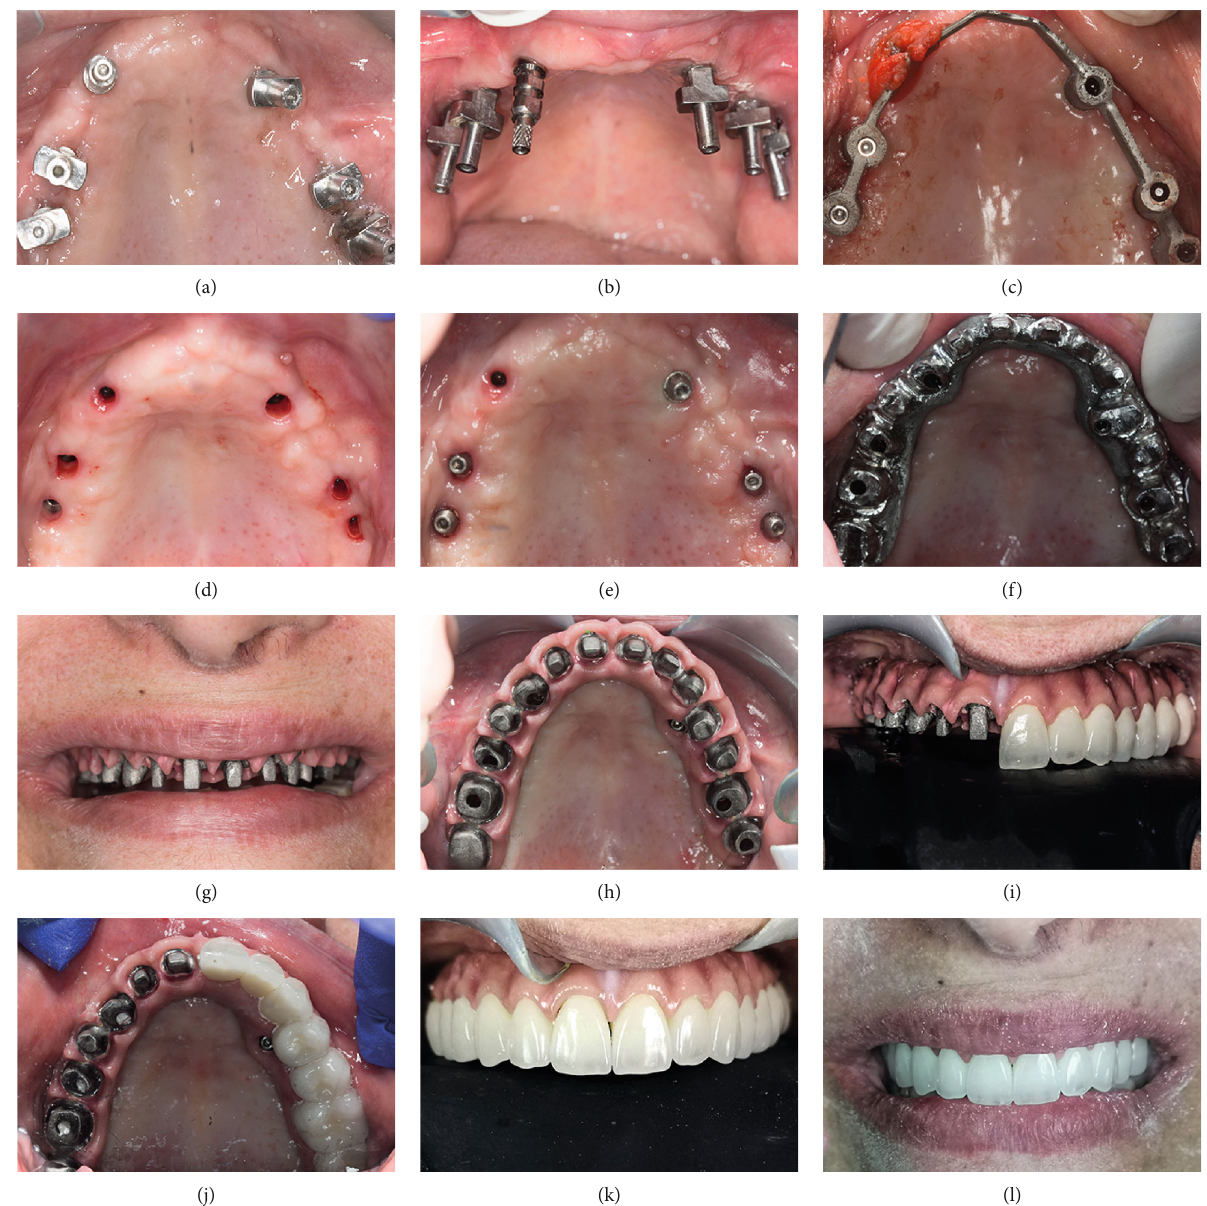
Figure 6: Final rehabilitation of the maxilla: (a, b) Pictures of the impression copings over their respective implants. (c) Passivity fi t check using a milled bar. (d) Occlusal view of the maxilla with abutments o ff . (e) Occlusal view of the maxilla showing fi ve straight multiunit abutments mounted over their respective implants. (f) Try-in of the fi nal milled mesostructure. (g, h) Try-in of the mesostructure after it was layered with pink ceramic. (i, j) Try-in of the individual crowns over the mesostructure. (k, l) Maxillary work